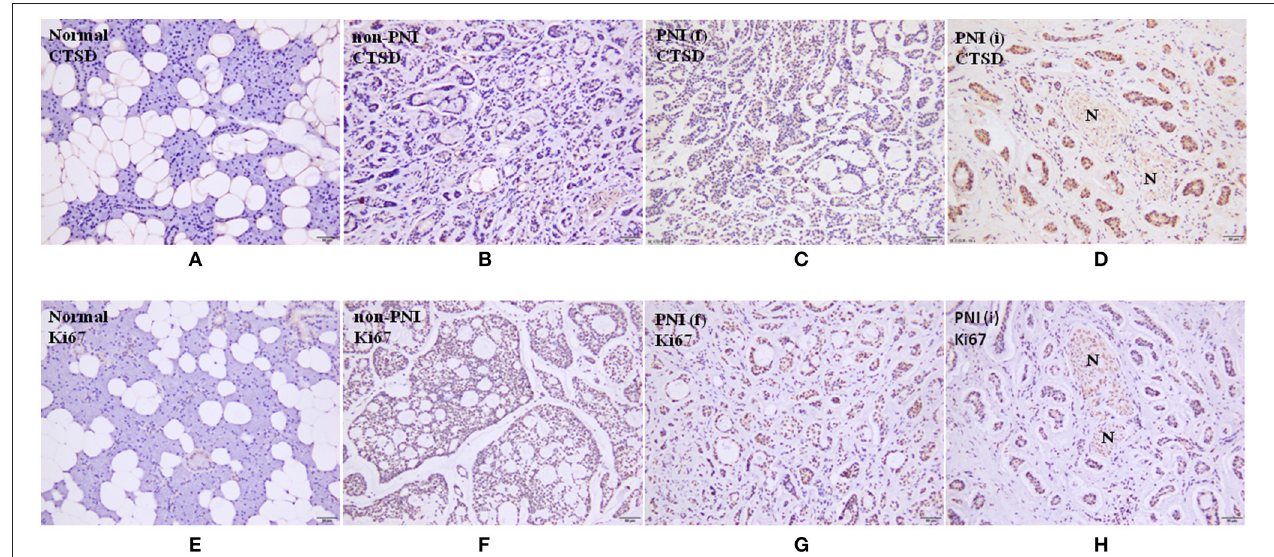
FIGURE 1 | (A-D) are immunohistochemical staining of CTSD, ( × 200). (E-H) are immunohistochemical staining of Ki67, (200 × ). N represents nerve. Normal means normal salivary gland. Non-PNI means non PNI group of SACC. PNI(f) means far away nerve of SACC with PNI group. PNI(i) means nerve invasion frontier of SACC with PNI